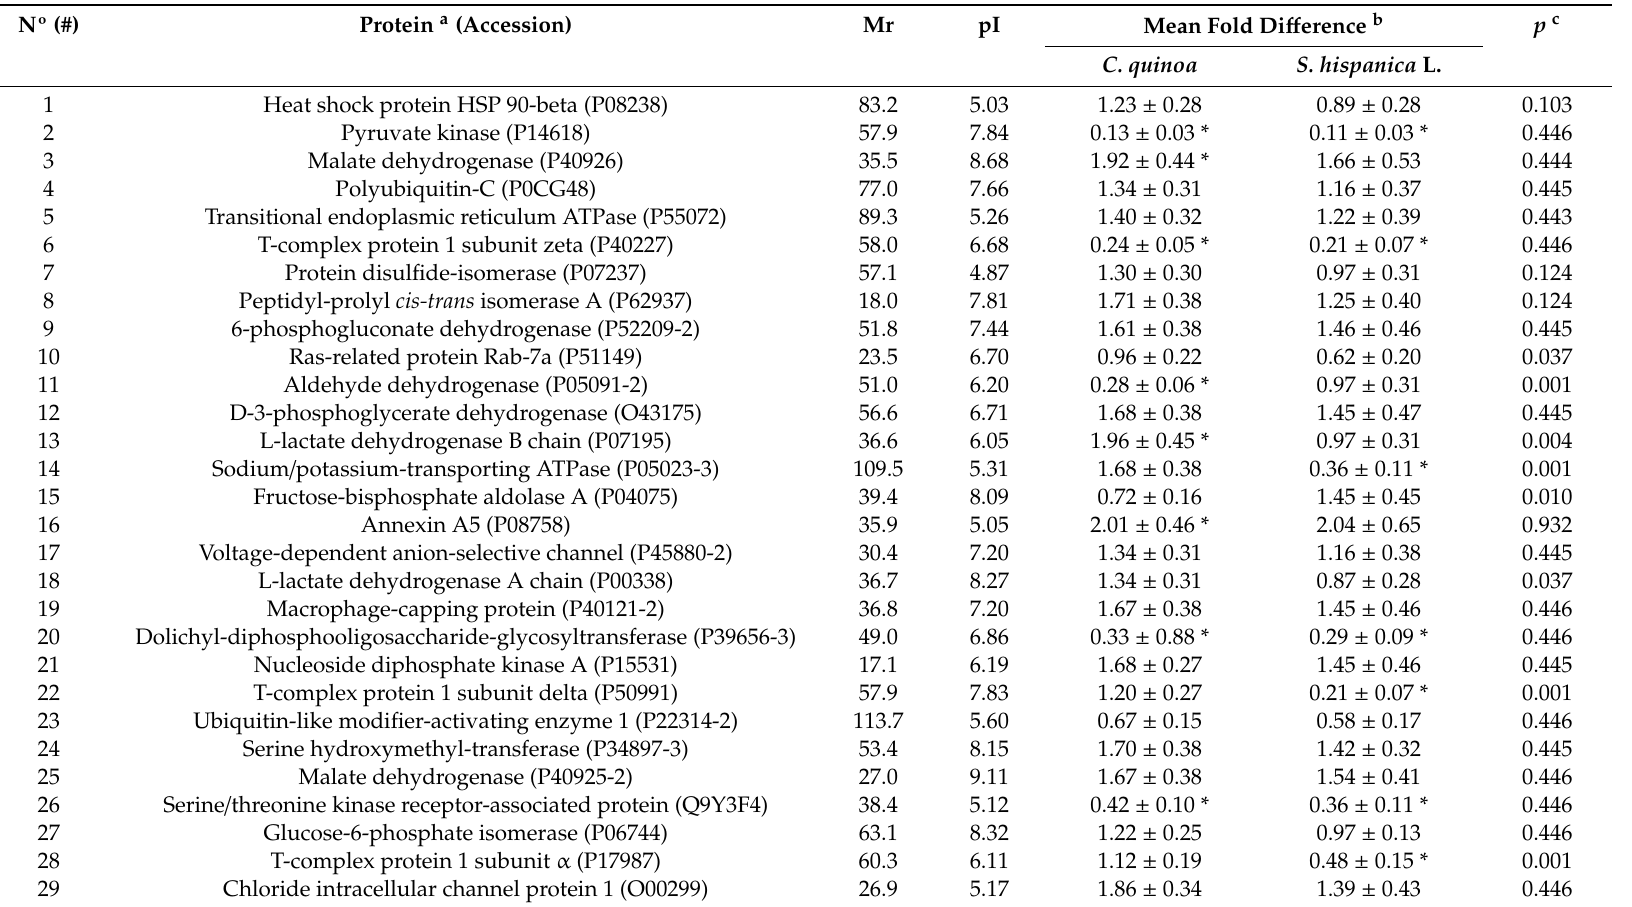
Table 1. Proteins identified by RP-LC-MS / MS in human-like macrophage cells incubated with extracts from Chenopodium quinoa and Salvia hispanica L. compared to untreated